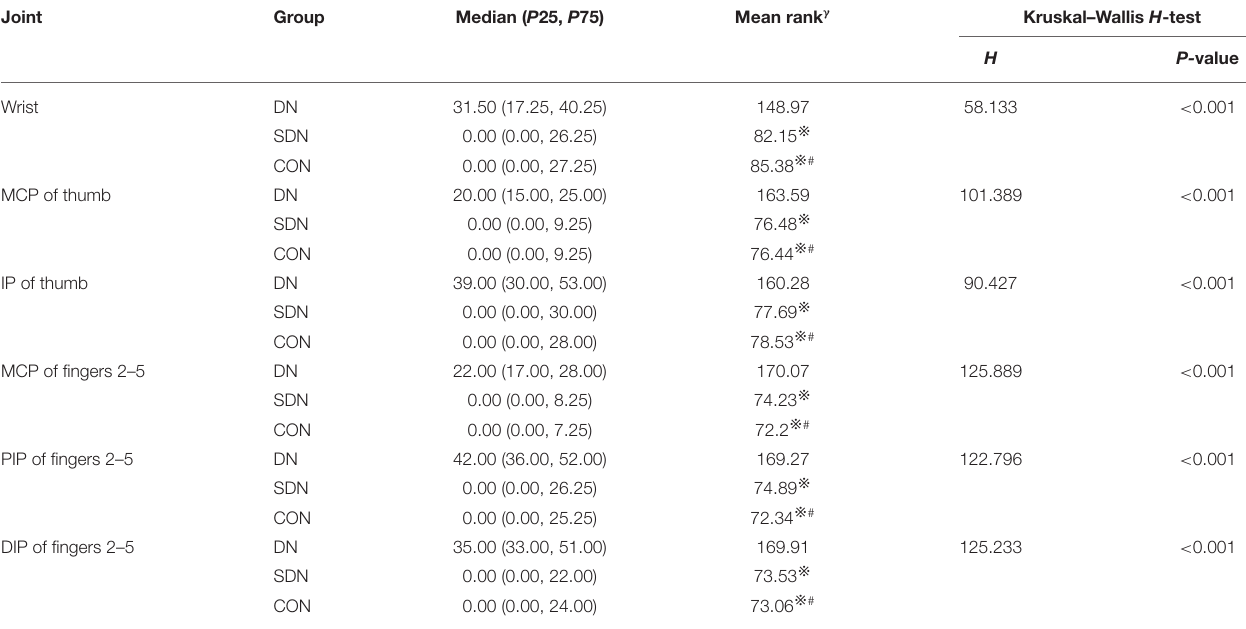
TABLE 8 | Change of joint flexion angles in resting position before and after each treatment.